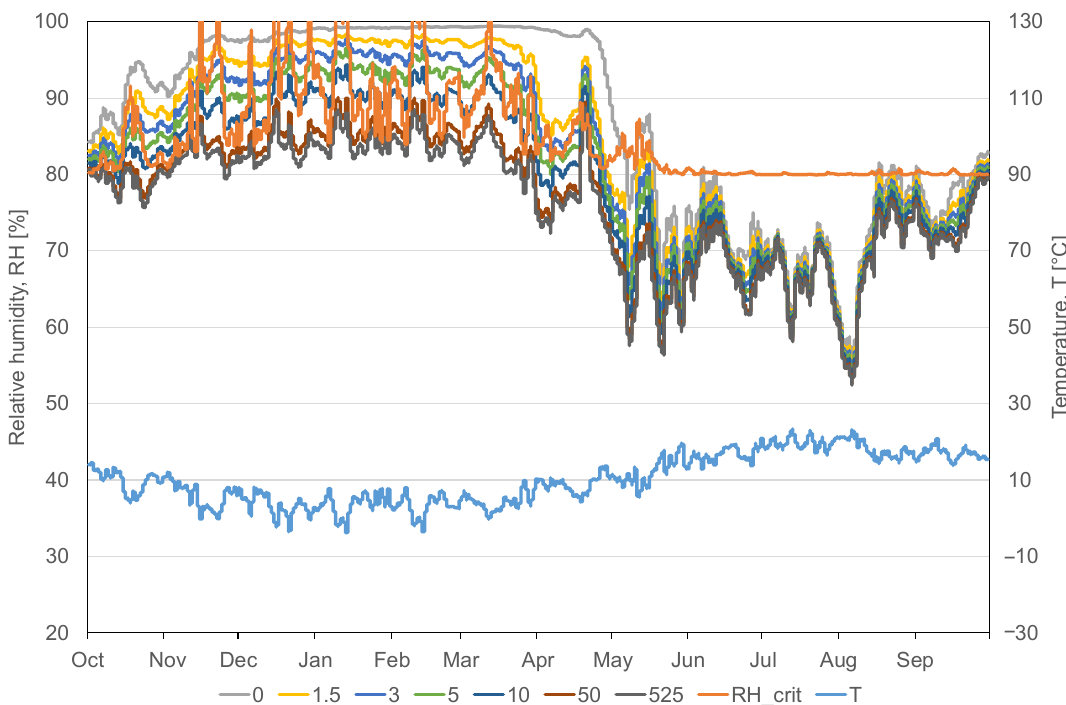
Figure 4. Running average of relative humidity and temperature behind the wind barrier (point A) for internal humidity class 3 and thermal insulation of mineral wool.